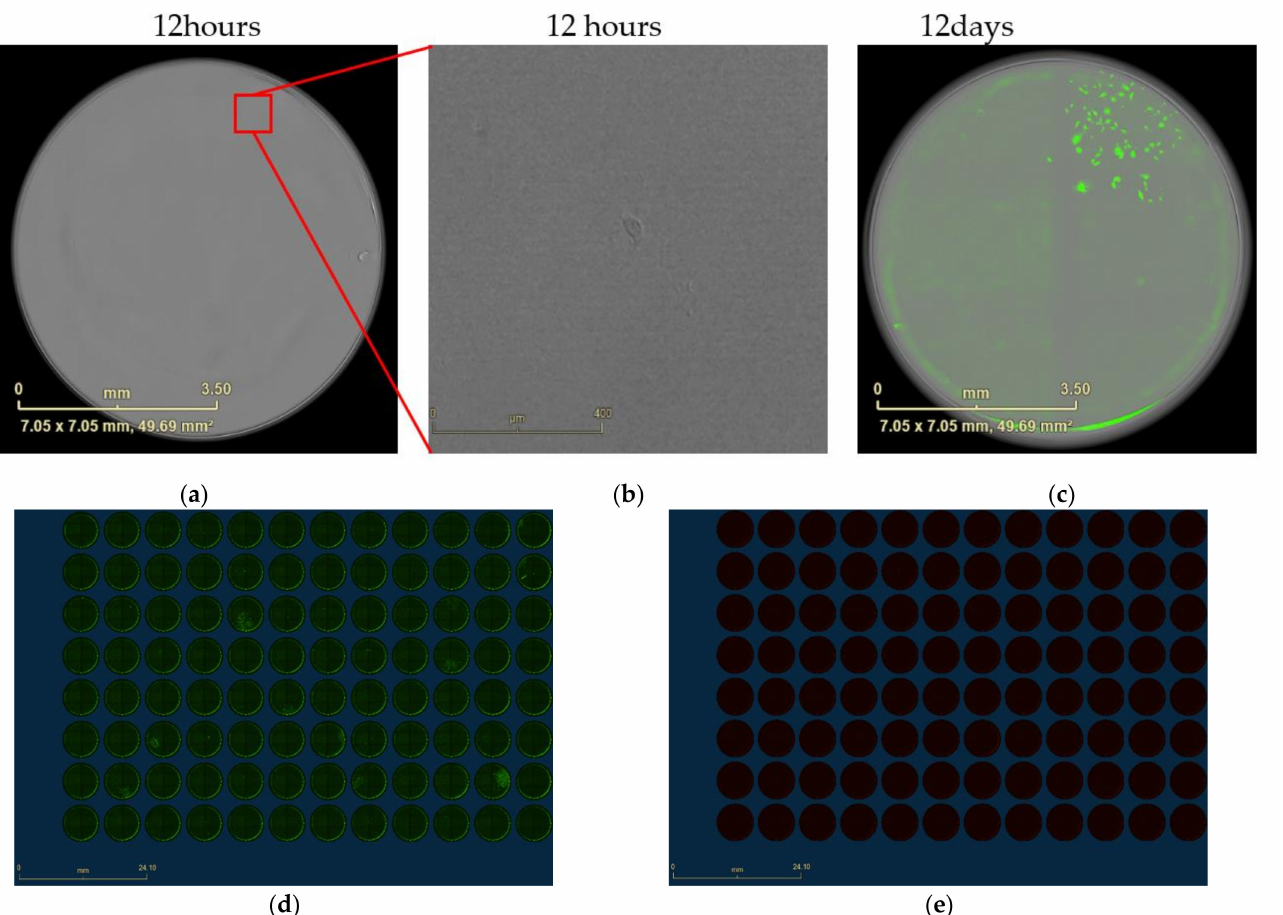
Figure 5. IncuCyte ® S3 whole well image of the 96-well plate scanning ( a – e ). ( a ) Image from 96-well plate scanned after 12 h incubation by bright phase, scale bars represent 3.5 mm. ( b ) Image enlargement (IE) from ( a ), scale bar = 0.4 mm ( c ) The same well scanned after 12 days incubation with overlap of fluorescence image and bright field image. Scale bars represent 3.5 mm. ( d ) Expression of eGFP in diluted cells detected by direct green fluorescence after 12 days incubation. ( e ) Expression of TurboFP635 in diluted cells detected by direct red fluorescence after 12 days incubation. Scale bars represent 24.1